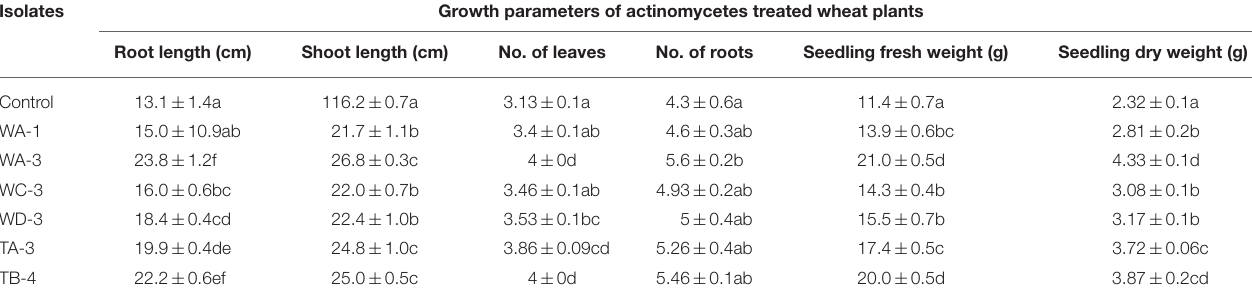
TABLE 4 | Effect of selected actinomycetes on the growth of Wheat ( Triticum aestivum ).